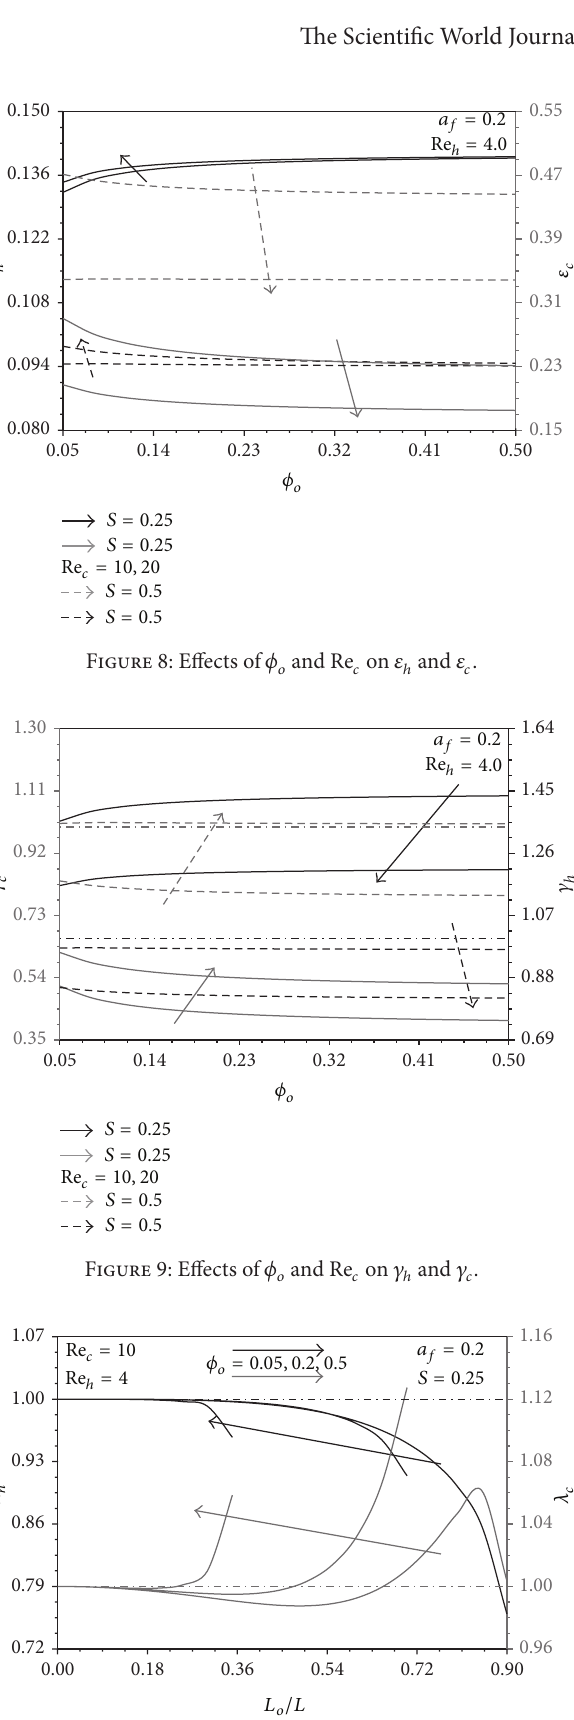
Figure 10: Effects of 𝐿 𝑜 /𝐿 and 𝜙 𝑜 on 𝜆 ℎ and 𝜆 𝑐